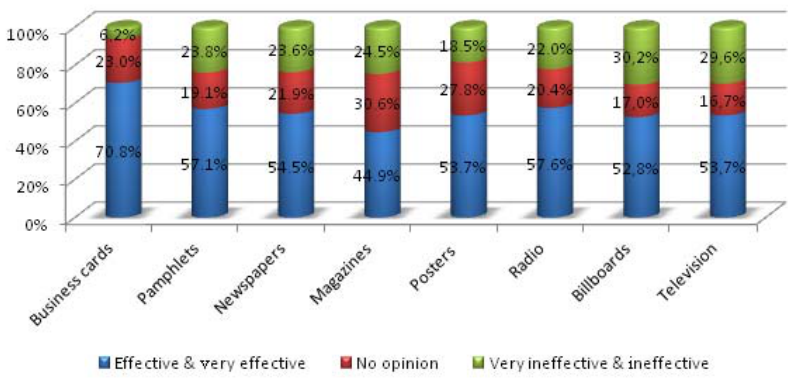
Fig. 5. Frequency analysis of the effectiveness of using traditional marketing tools